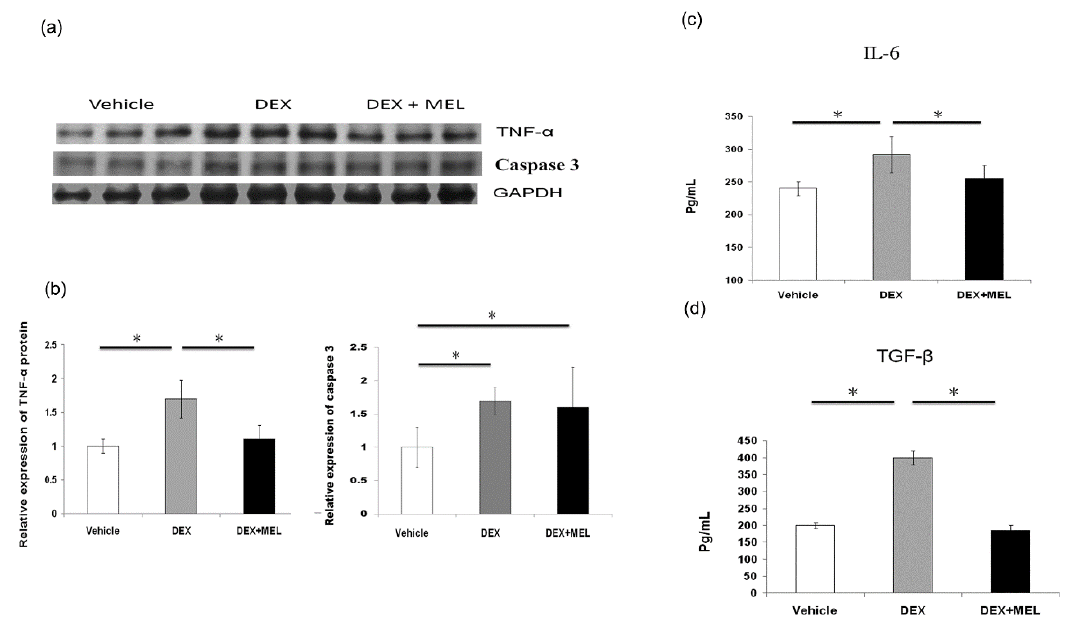
Figure 5. Inflammatory and apoptosis study. Increased tumor necrosis factor alpha (TNF- α ) and